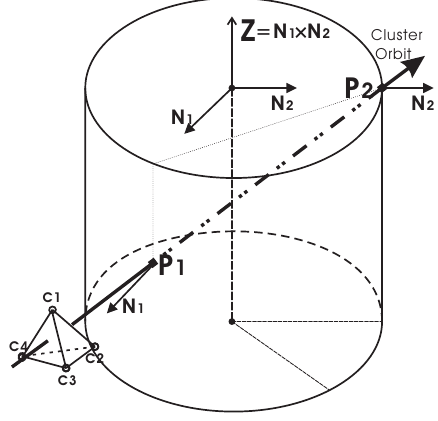
Fig. 1. Sketch of the Cluster constellation passing through a flux rope, which meets with the certain magnetic contour plane twice, at the positions of P 1 and P 2 . Using the Triangulation Method, the normal directions of them can be obtained, marked as N 1 and N 2 , both of which have no z components. Thus, the cross product of them should point to the flux rope